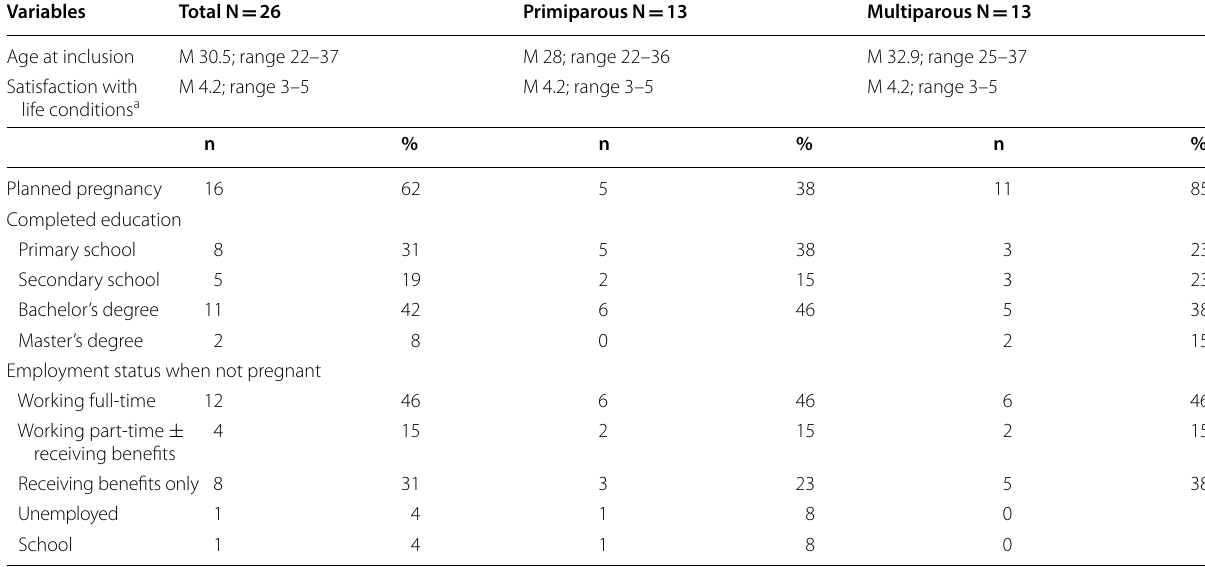
Table 1 Demographic characteristics of the sample